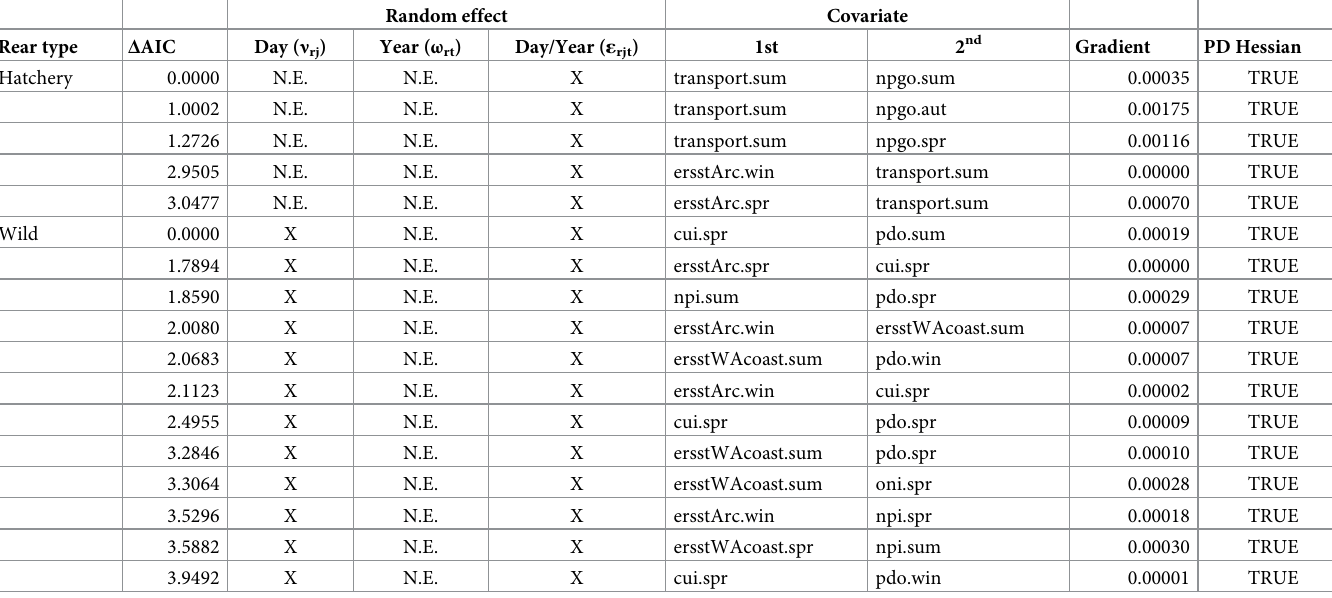
Top models for each origin type based on the random effects and number of marine covariates. The gradient is a measure of the likelihood surface for the maximum likelihood estimate, PD Hessian stands for positive definite Hessian, and N.E. stands for not